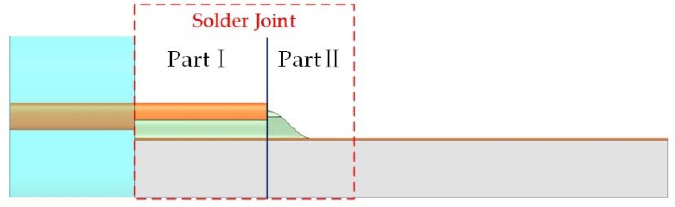
Figure 3. Segmentation model of the lead wire interconnection.